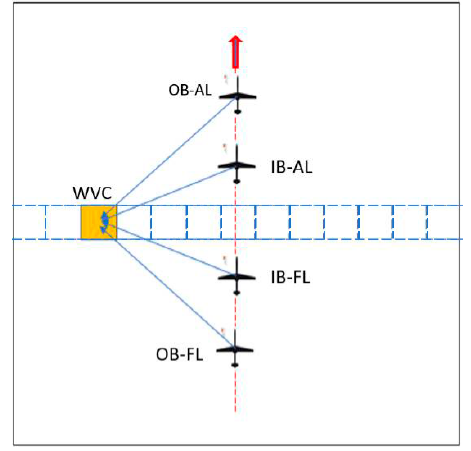
Figure 3. HIWRAP viewing a selected wind vector cell at 4 different azimuth looks: outer beam fore-look (OB-FL), inner beam fore-look (IB-FL), inner beam aft-look (IB-AL), and outer beam aft-look (OB-AL) as the GH moves from bottom to top.